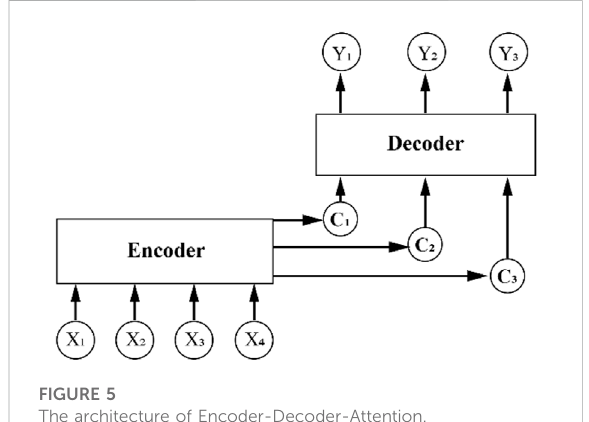
FIGURE 5 The architecture of